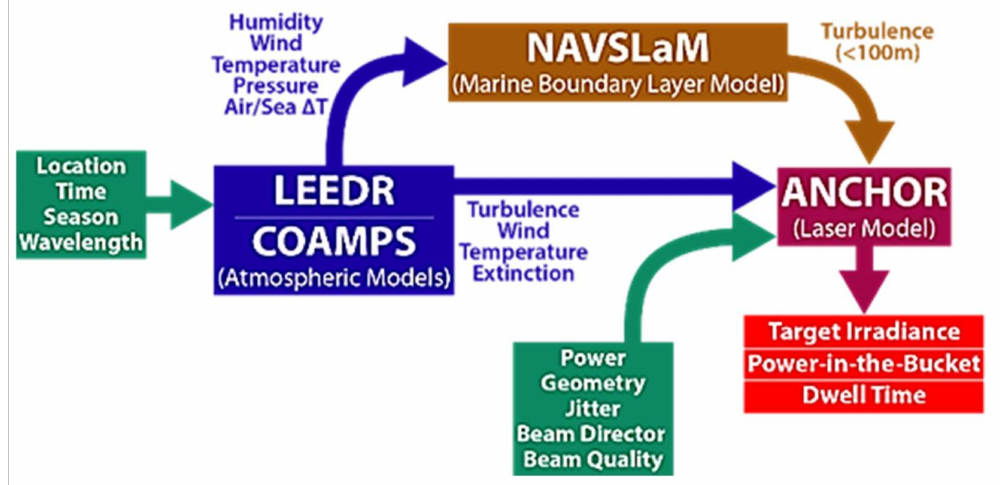
Figure 4. The NPS laser performance code